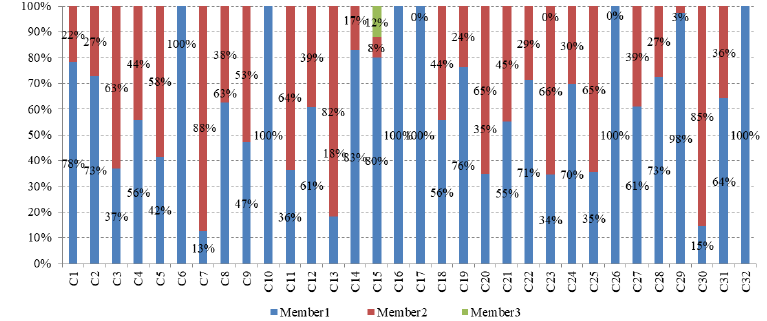
Fig. 3. Distribution of editing actions among group members for each group of students of